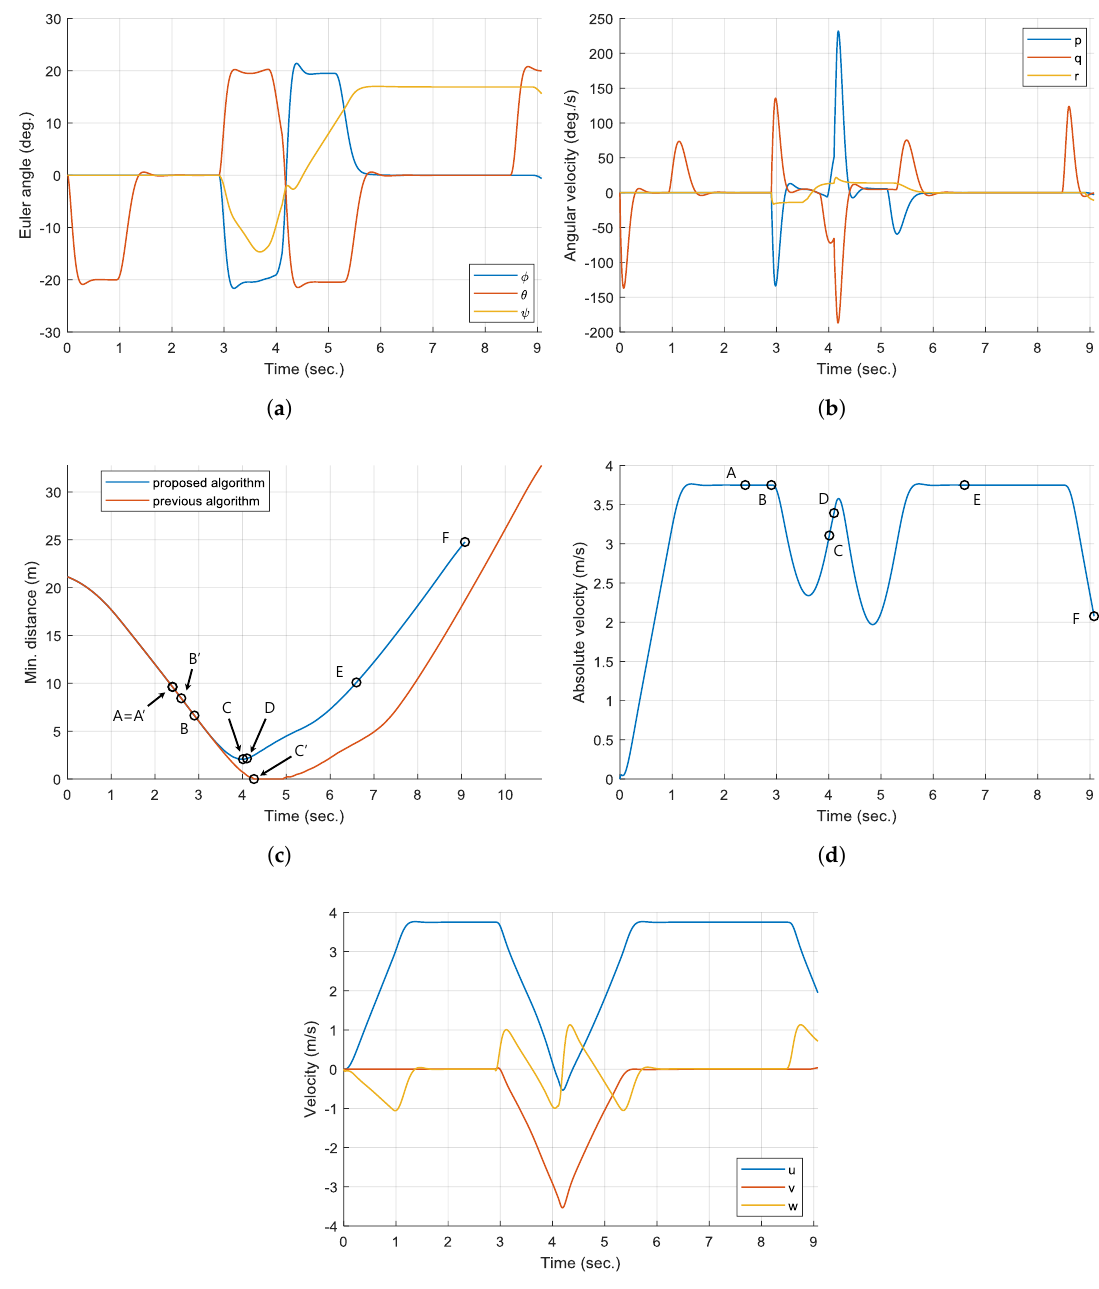
Figure 10. Time histories of UAV-related variables (Simulation II): ( a ) attitude, ( b ) body rate, ( c ) minimum distance between UAV and obstacle, ( d ) absolute velocity, and ( e ) velocity (body-fixed coordinate